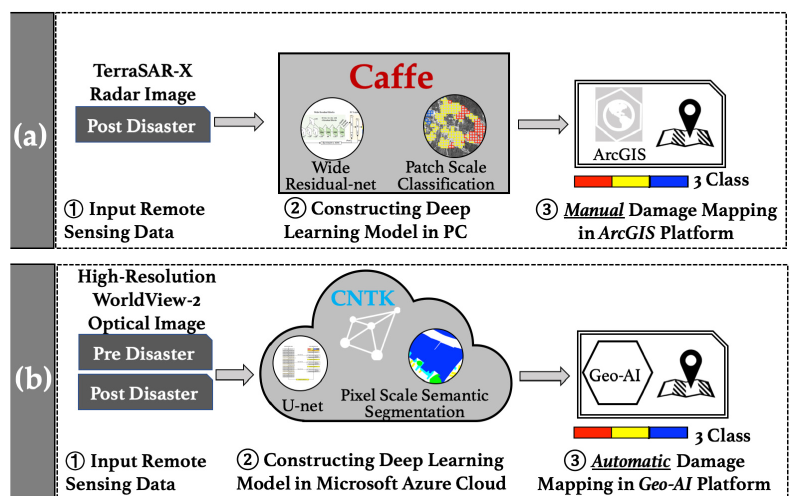
Figure 14. ( a ) Data from TerraSAR-X Radar Image; ( b ) Data from WordView-2 optical Image. The flowchart of deep learning framework for detecting Tsunami damage: Case study of the 2011 Tohoku tsunami [50,102].